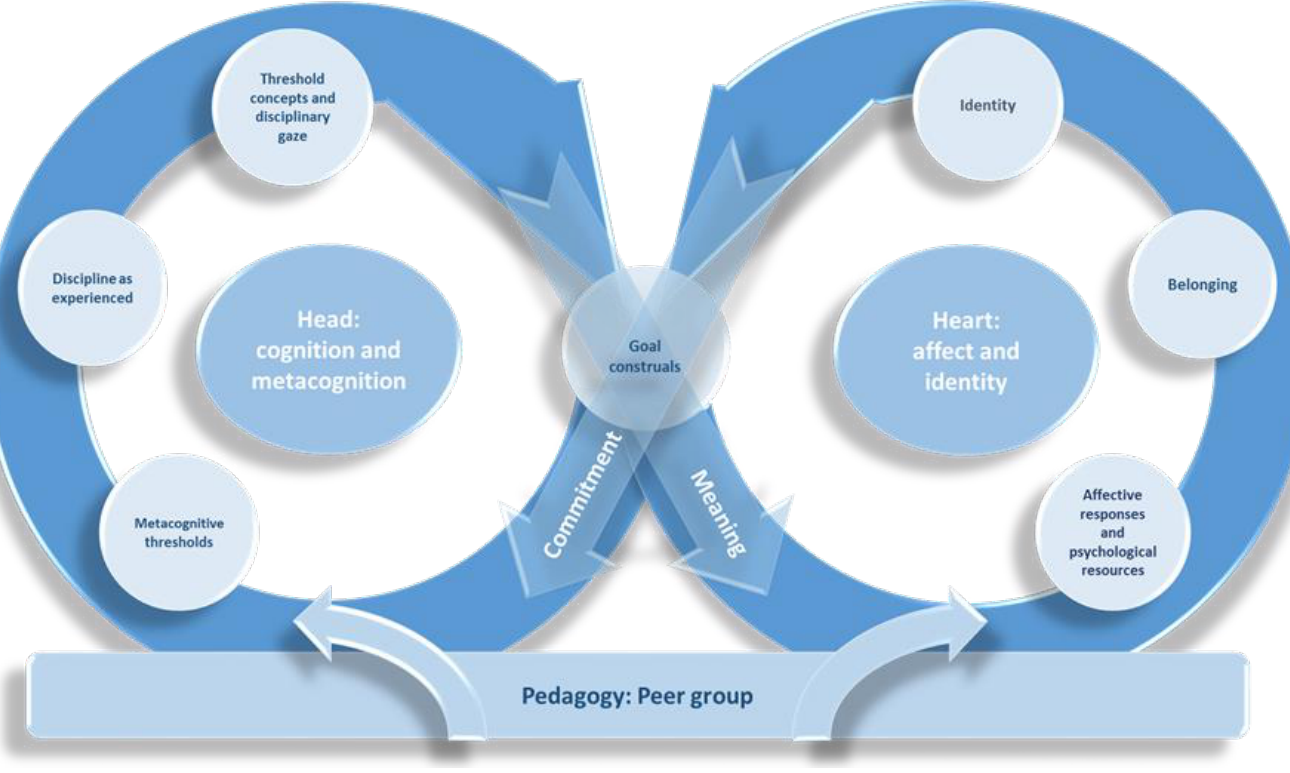
Figure 4 : A model of disciplinary